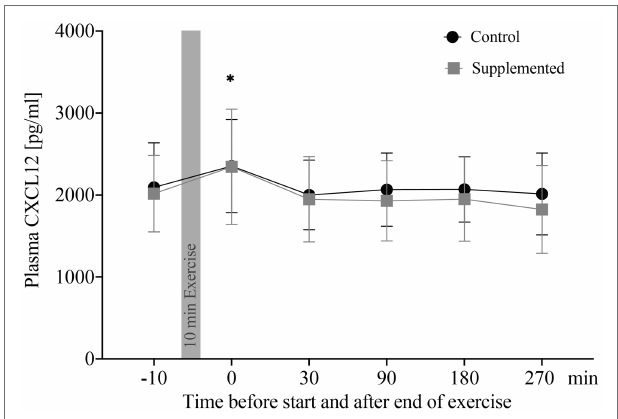
FIGURE 1 | Plasma CXCL12 concentrations in pg/ml ( n = 18). Values are mean ± SD. Differences from baseline are indicated by *, with * p < 0.05.